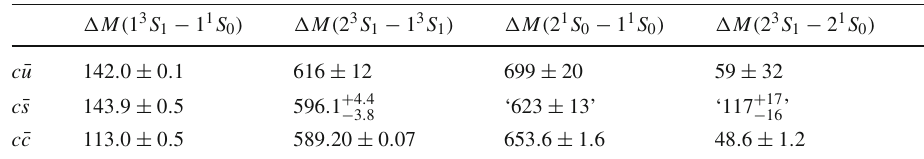
Table 2 Mass splittings